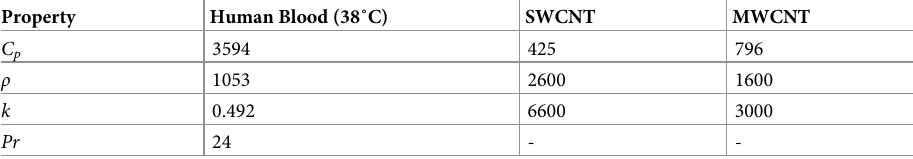
Table 1. Thermo-physical characteristics. Property Human Blood